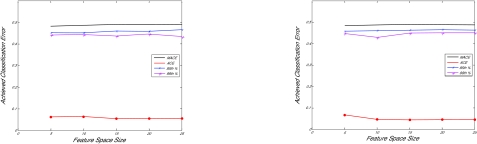
PACE analysis using a SVM-based classifier using the t-test scoring criterion, with a 0.6 MAC threshold. Left Panel: performance without peak selection. Right panel: performance with peak selection.